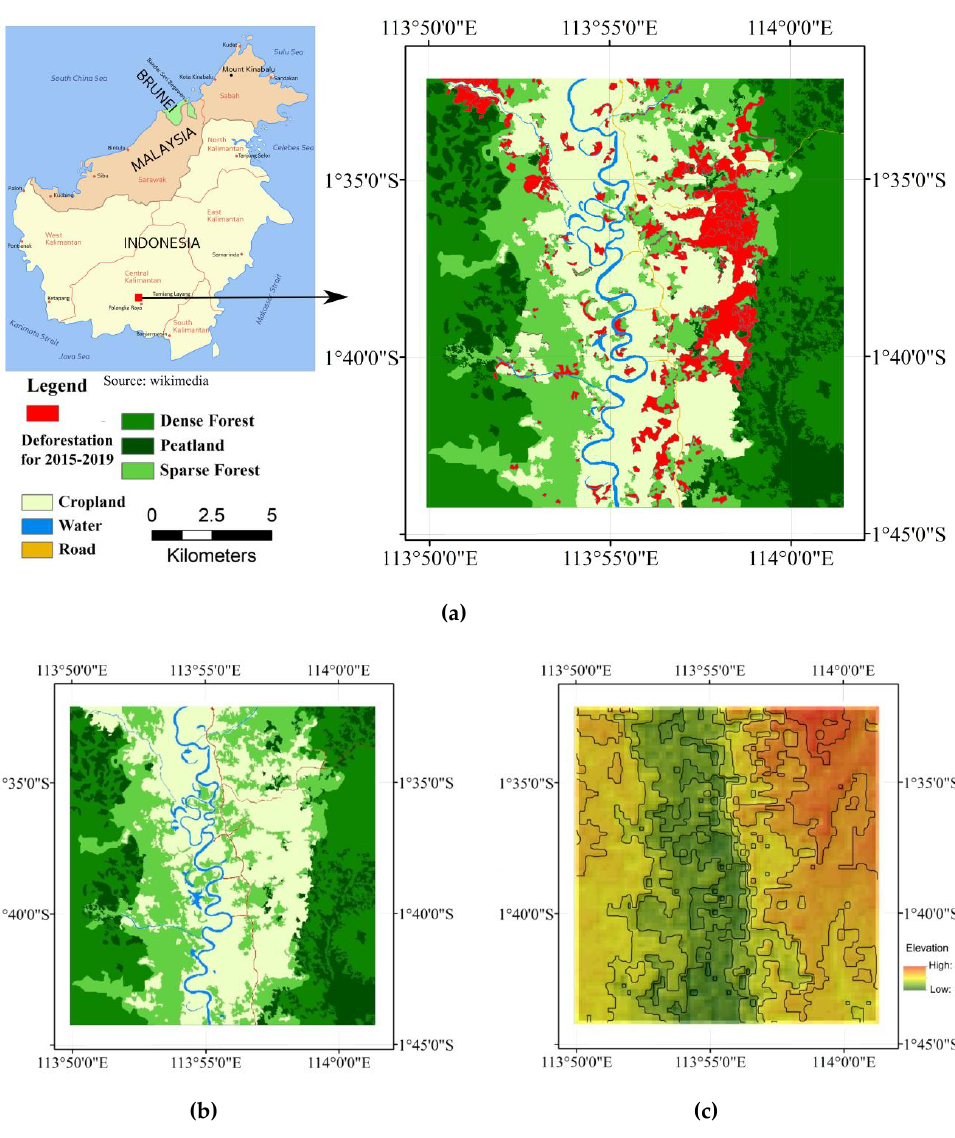
Figure 1. ( a ) Deforestation map, ( b ) land use map, and ( c ) topography in the study area.